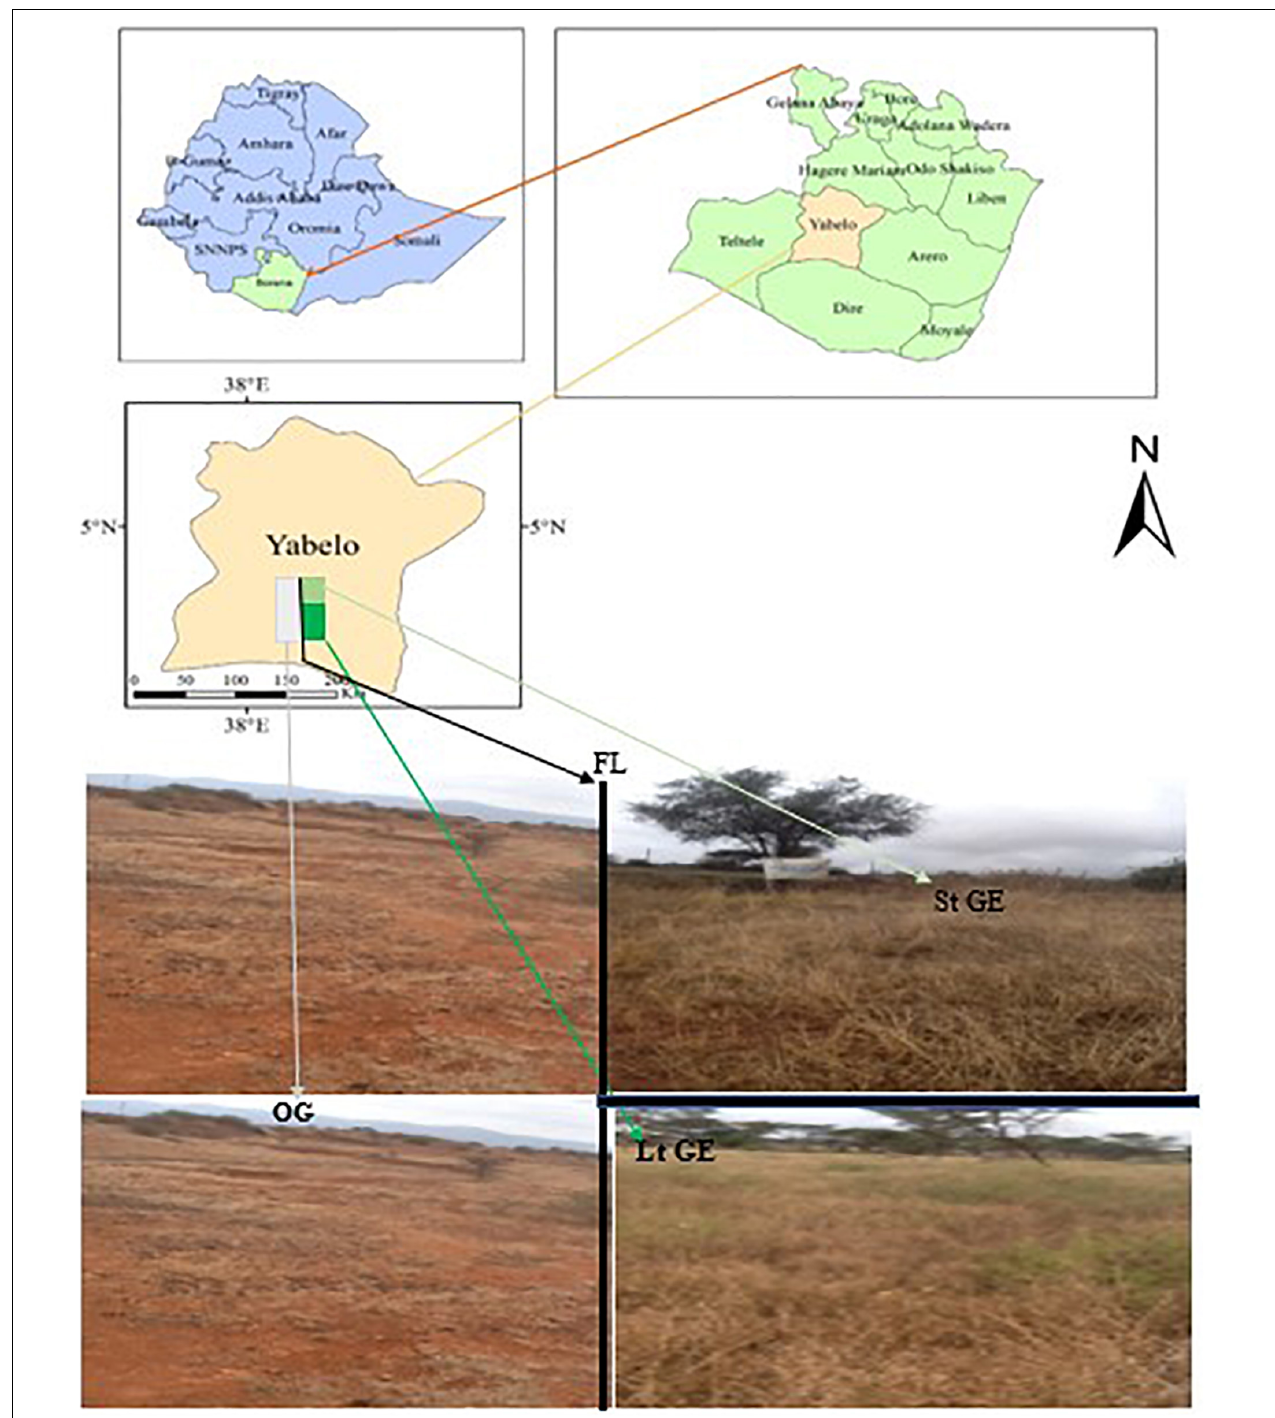
FIGURE 1 | Location of the study area and landscape of study sites. The fence line is clearly visible with a sharp variation of vegetation density and cover inside and outside. Photos by YF. FL, fence line; StGE, short-term grazing enclosure; LtGE, long-term grazing enclosure; OG, open-grazing.